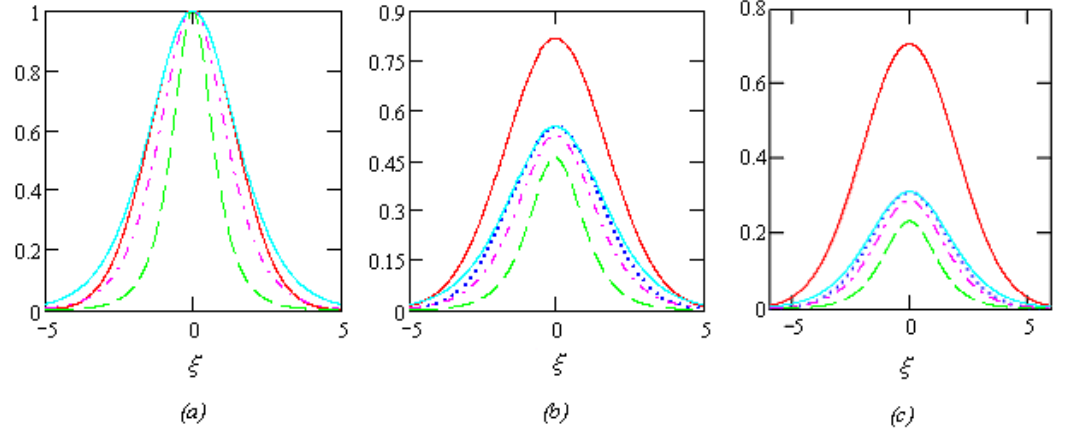
( ξ , ζ ) | (blue dotted line), G r